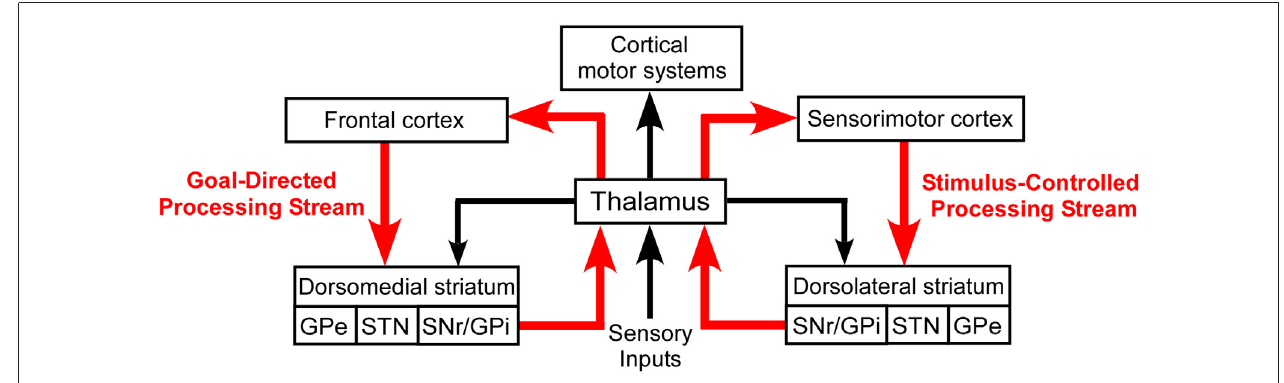
FIGURE 1 | Basal ganglia processing streams involved in the expression of goal-directed and stimulus-controlled behaviors. According to the prevailing view, virtually all sensory information is transmitted to the striatum by a series of thalamocortical and corticostriatal connections. The thalamus also sends direct projections to the striatum, but its functional influence is poorly